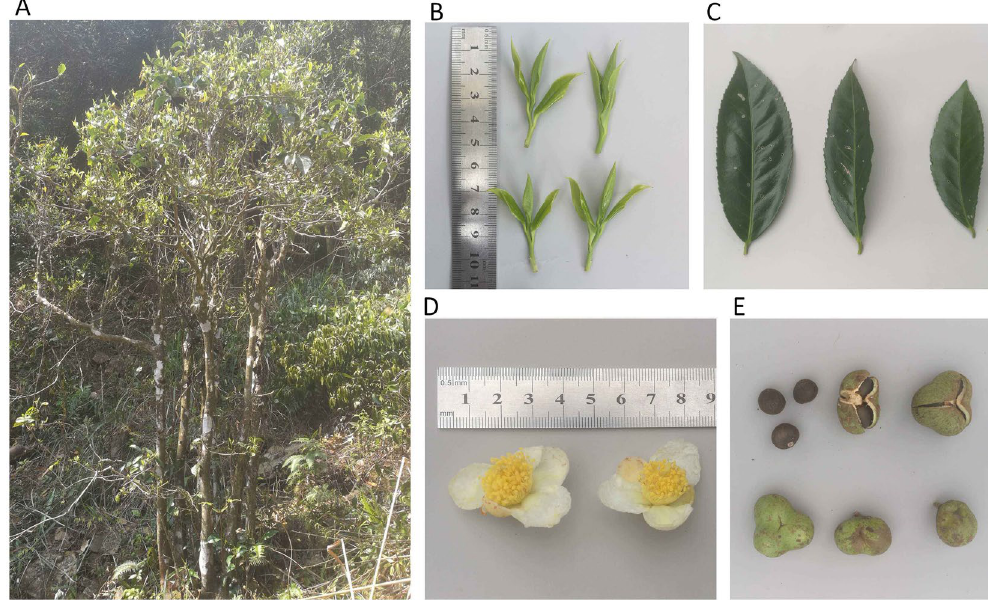
Figure 1. Morphological characteristic of Baiyacha: ( A ) a typical plant, ( B ) young shoots, ( C ) leaves, (D ) flowers, and ( E ) fruits and